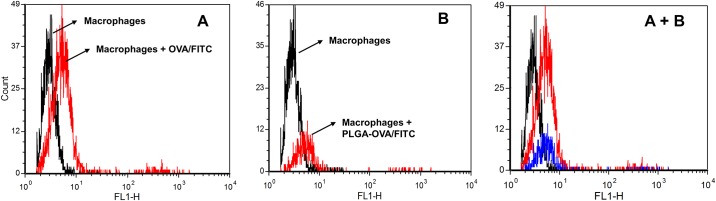
Flow cytometric evaluation of cellular uptake of PLGA NP preparations by canine macrophages.Flow cytometry analysis of canine macrophages treated with fluorescent PLGA/OVA/MPLA NPs. Day 7 canine macrophages cultures (1x106) were incubated with 50 μg/mL of OVA-FITC or PLGA/OVA-FITC/MPLA NP. After 24 hours, nonadherent cells were harvested and analyzed by flow cytometry. One representative experiment is shown. (A) Histogram of macrophages incubated with 50 μg/mL OVA-FIT for 24 hours. (B) Histogram of macrophages incubated with 50 μg/mL PLGA/OVA-FITC/MPLA for 24 hours.